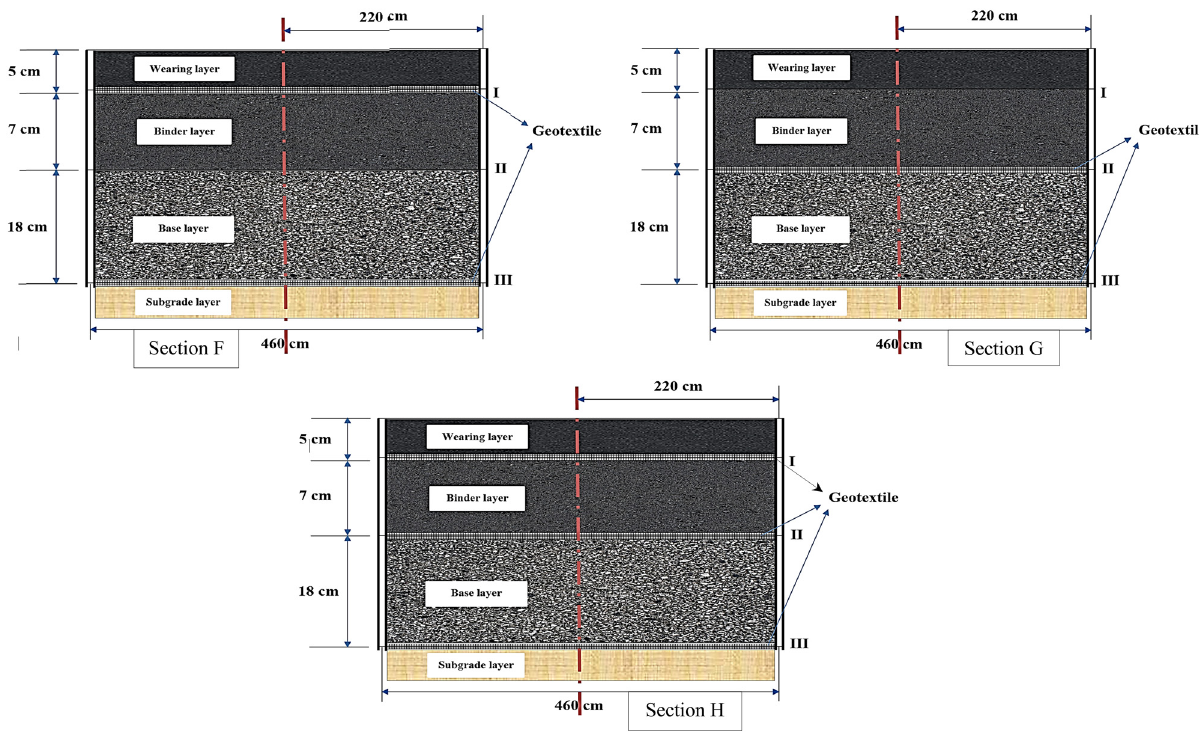
Figure 7: Sections F – H in the constructed road